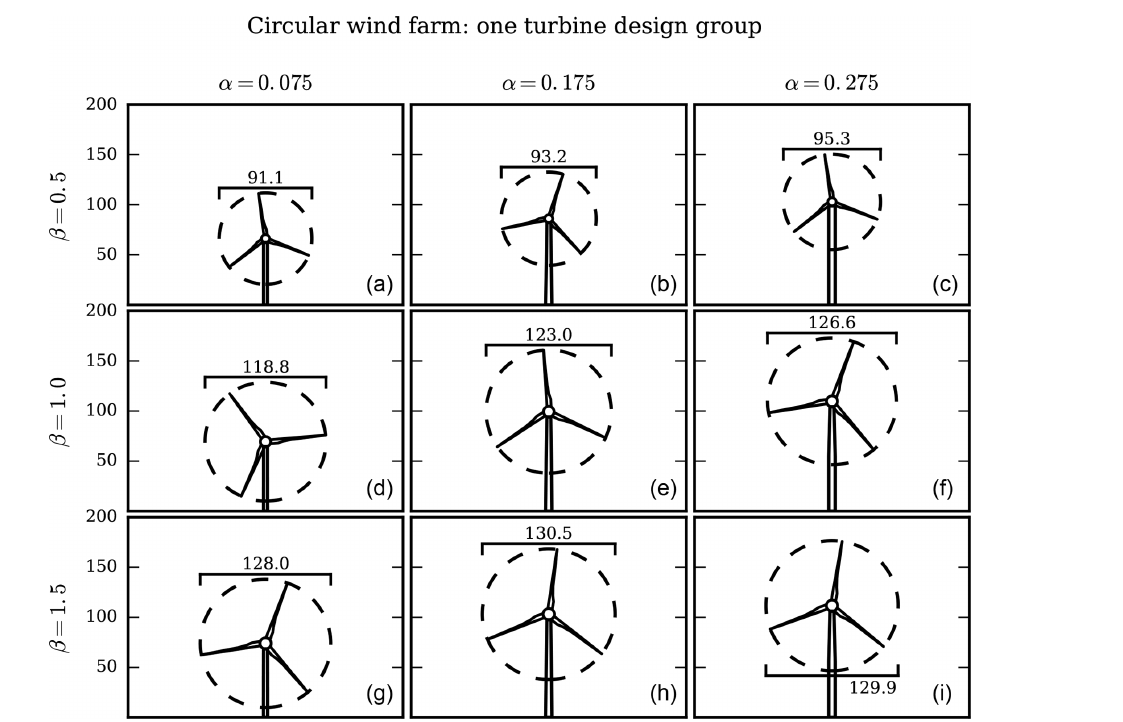
Figure 11. The optimal turbine heights and rotor diameters for the optimization runs with coupled layout and turbine design with homoge- neous turbine design throughout the circular wind farm. Each column shows a different shear exponent, with α = 0 . 075, 0 . 175, and 0 . 275 from left to right. Each row shows a different farm spacing multiplier, with β = 0 . 5, 1 . 0, and 1 . 5 from top to bottom.